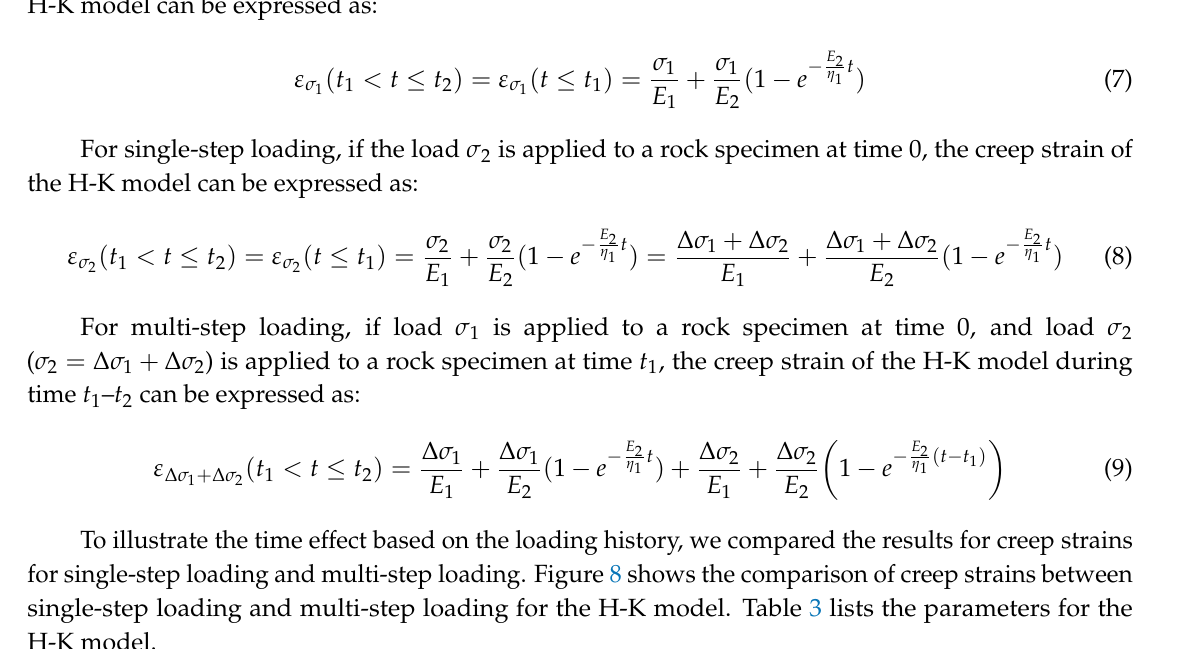
Table 3. Parameters of the H-K model. σ 0 (MPa)